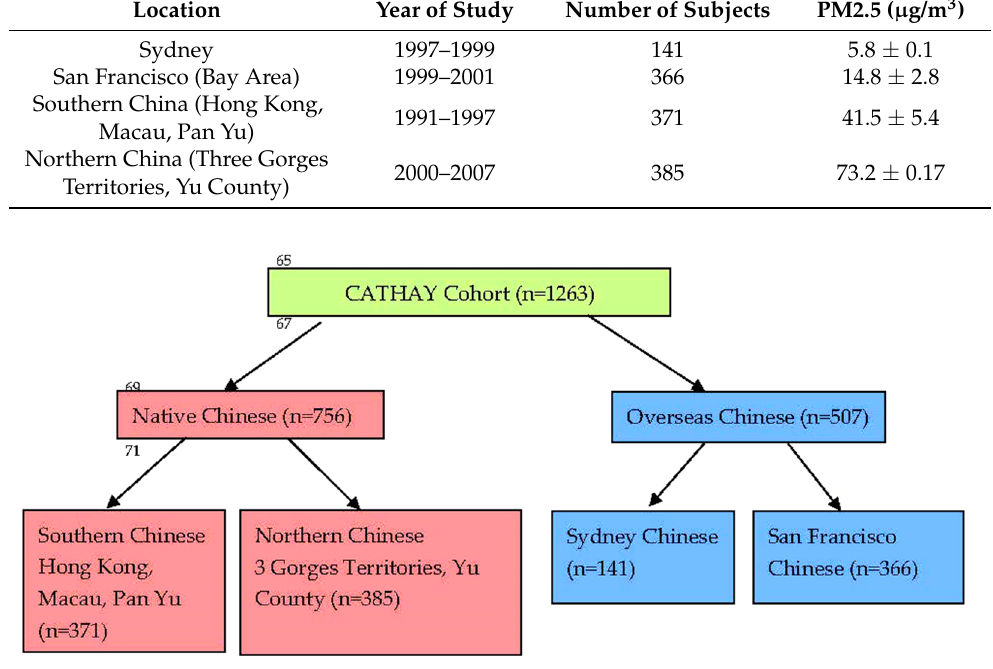
Figure 1. Schematic diagram of enrolment in the CATHAY Study. Overall, 1263 Chinese (507 overseas Chinese and 756 native Chinese) with complete and accessible data were recruited. Table 1. Mean yearly PM2.5 air pollution exposure.